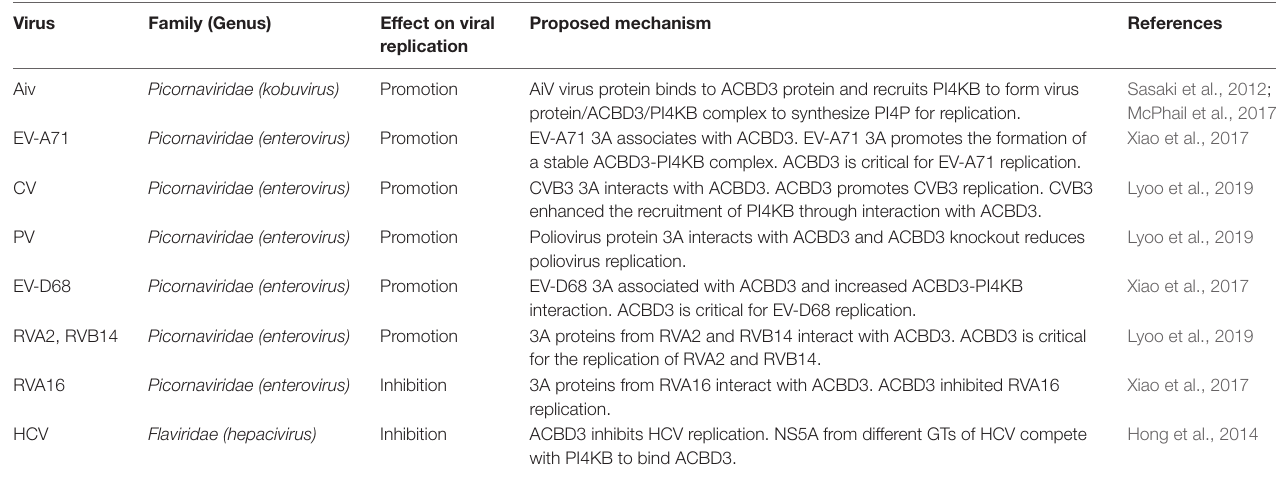
TABLE 1 | Summary of the role of ACBD3 in viral